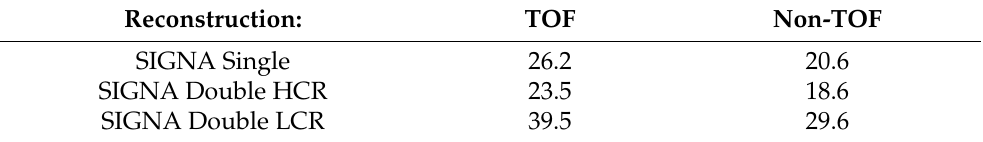
Table 6. Background variability [%] at 48 updates for the 1 pixel scale for the different SIGNA